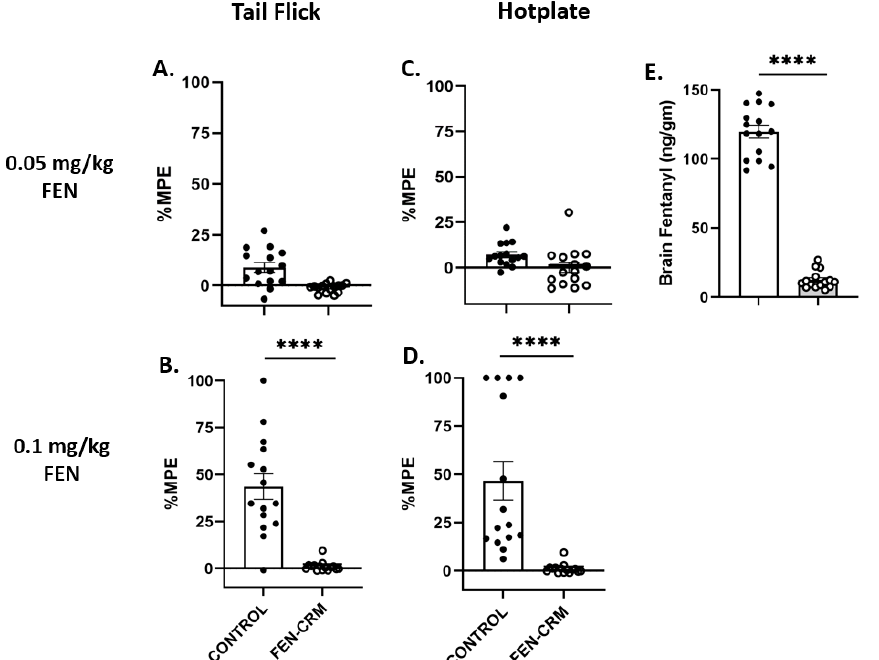
Figure 3. Vaccine efficacy against FEN-induced anti-nociception and FEN distribution in female Sprague Dawley rats. Rats were vaccinated with PBS (CONTROL, open bars, N = 15) or (FEN-CRM, gray bars, N = 15) at day 0, then boosted at 3 and 6 weeks. At 8–12 weeks post initial vaccination rats were administered one of two doses of FEN (0.05 mg/kg and 0.1 mg/kg) then tested in the tail flick ( A , B ) and hotplate ( C , D ) nociception assays. Data are presented as mean ± SEM %MPE (Maximal Possible Effect). Vaccinated rats showed no response to FEN-induced analgesia in the tail flick and hotplate assays whereas unvaccinated rats showed robust analgesic effects at the high FEN dose. Brain ( E ) FEN levels were obtained following administration of FEN (0.1 mg/kg, SC) at approximately week 20 post initial vaccination in the same rats that underwent analgesic testing. FEN was prevented from penetrating the brain in vaccinated rats but not unvaccinated rats. **** p < 0.0001 .